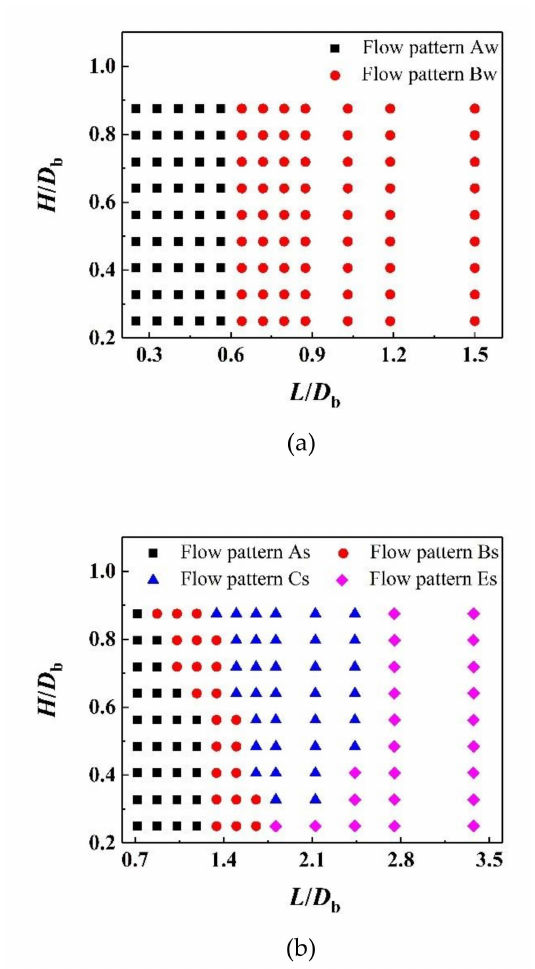
Figure 16. Flow pattern divisions according to the channel widths of the wavy vertical channel ( a ) and S-shaped curved channel ( b ) at Re Gr = 100 and Eo =